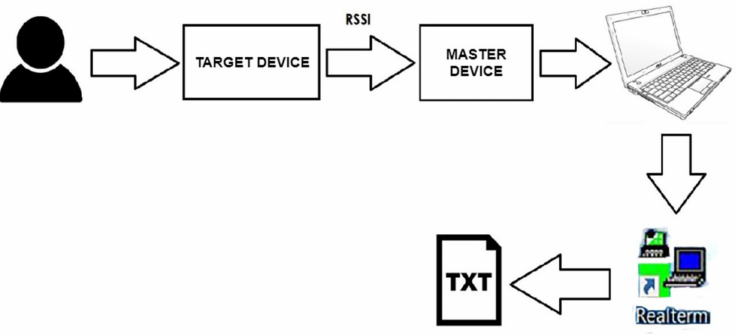
Figure 3. System framework.